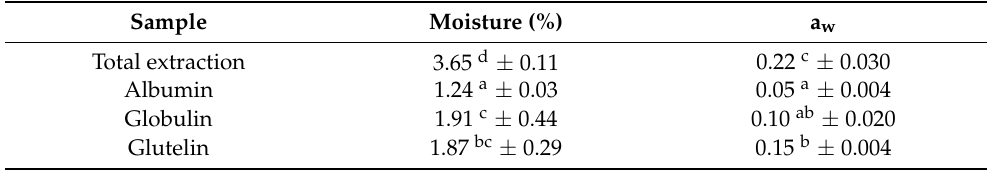
Table 1. Moisture content and a w of lyophilized protein.